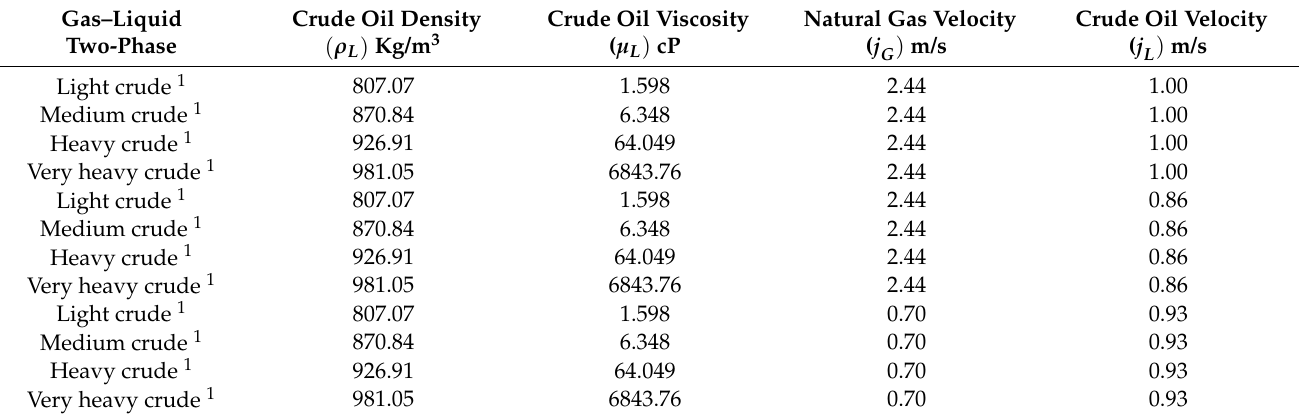
Table 3. Physical properties of two-phase